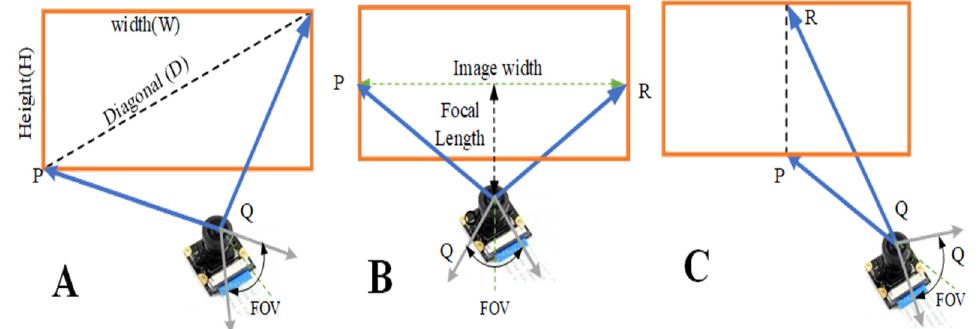
Figure 6. Different camera FOVs measurement situation, diagonal lengths ( A ), horizontal ( B ), and vertical ( C ).